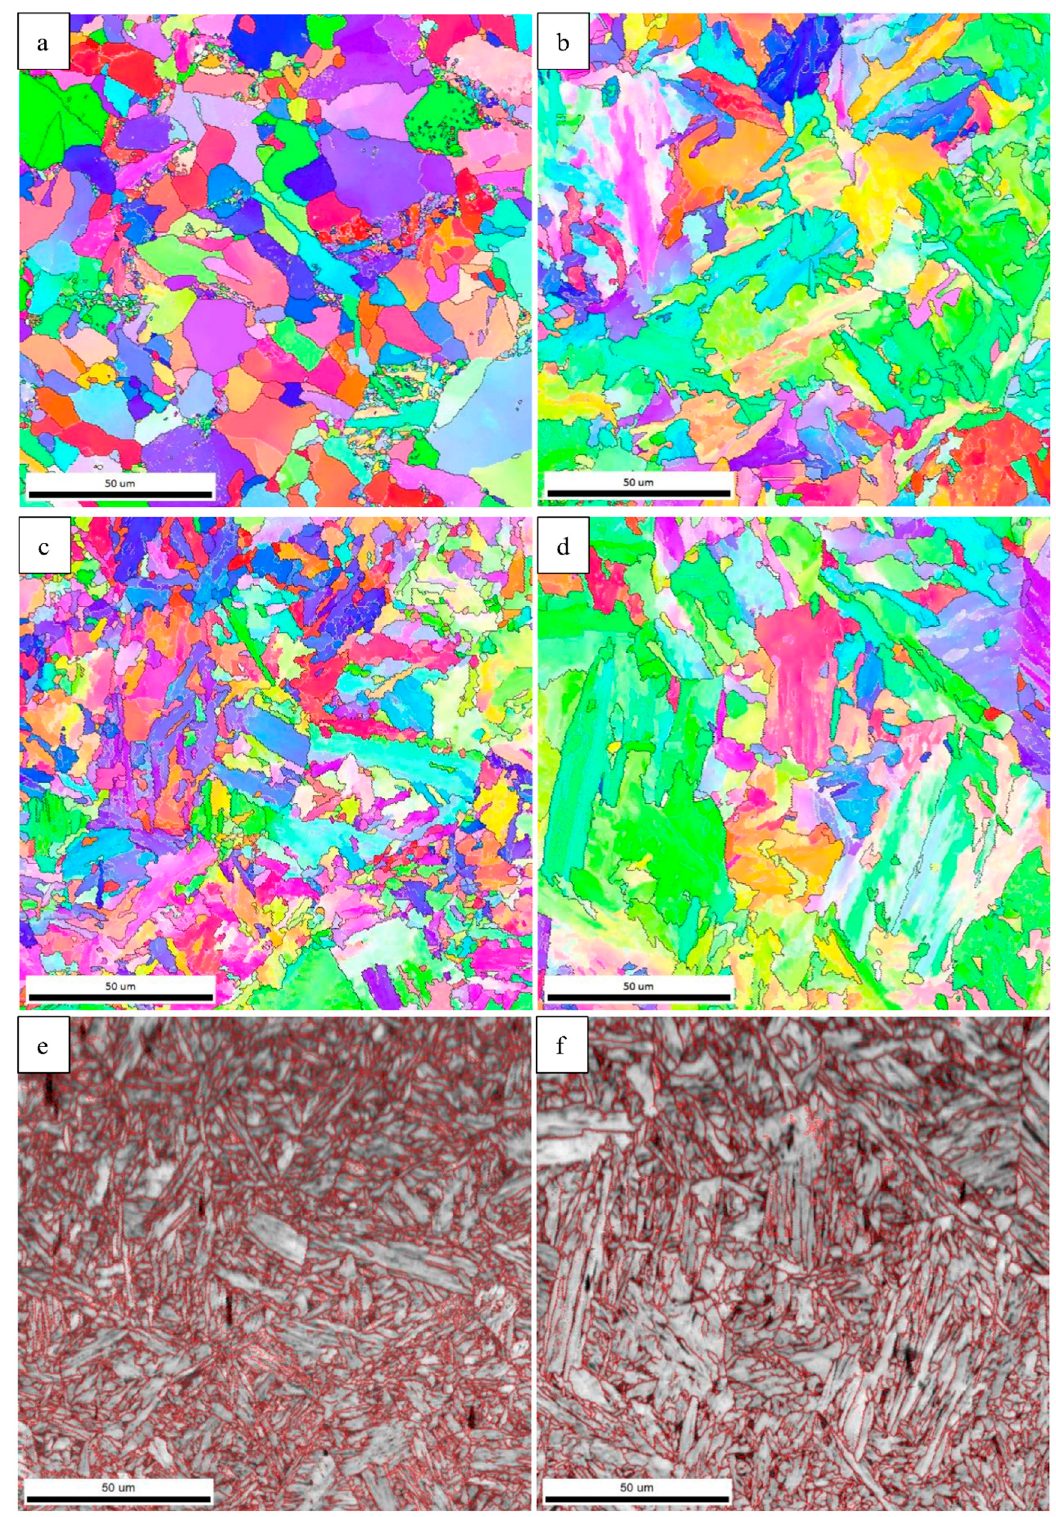
Figure 9. EBSD inverse pole figure for the simulated samples of ( a ) 120 kJ/cm, ( b ) 85 kJ/cm, ( c ) 65 kJ/cm, and ( d ) 35 kJ/cm with the white and black lines expressing the misorientation tolerance angle in the range of 2–15° and greater than 15°, respectively; image quality maps for the simulated samples of ( e ) 65 kJ/cm and ( f ) 35 kJ/cm with the red lines expressing the misorientation tolerance angle greater than or equal 2°.